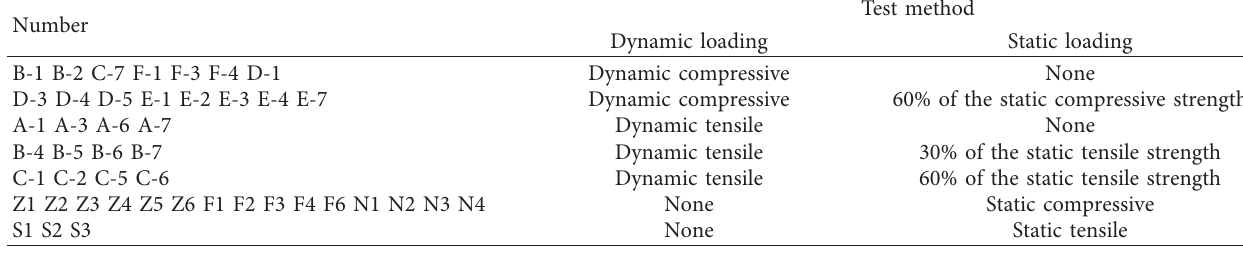
Table 1: Sample grouping and loading situation.